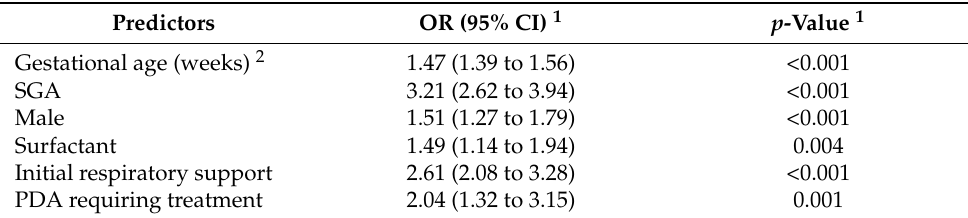
Table 1. Independent predictors of Bronchopulmonary